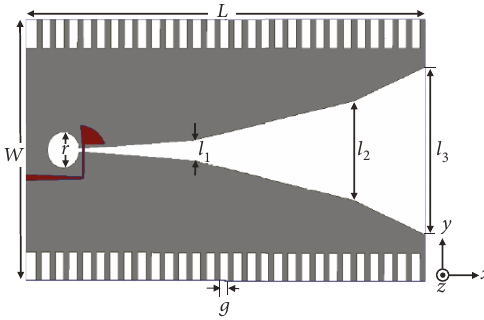
Figure 13: A linear tapered slot Vivaldi antenna